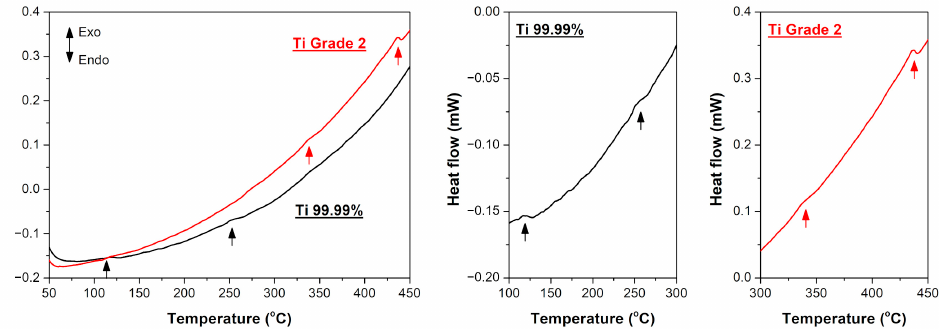
Figure 6. DSC curves representing heat flow as a function of annealing temperature for Ti 99.99% and Ti Grade 2.